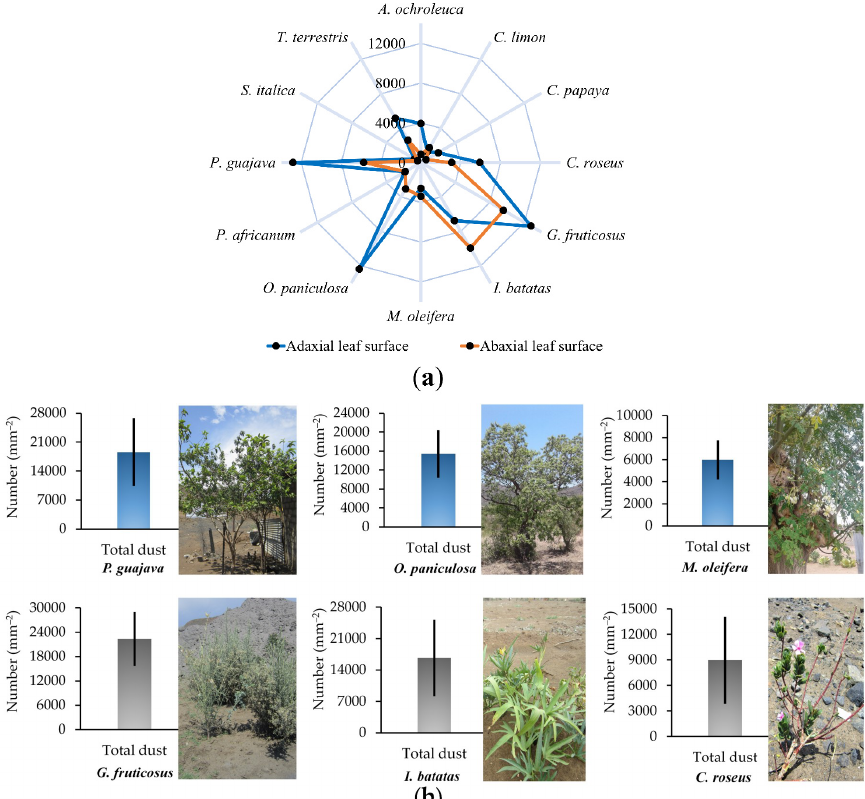
Figure 2. Dust particle accumulation by plants: ( a ) Mean total dust values (per mm 2 ) on adaxial and abaxial leaf surfaces of all assessed species; ( b ) Sum of mean particle counts ( ± SD) of both leaf surfaces of six species with higher dust collection in descending order. Trees (in blue) are followed by forbs (in